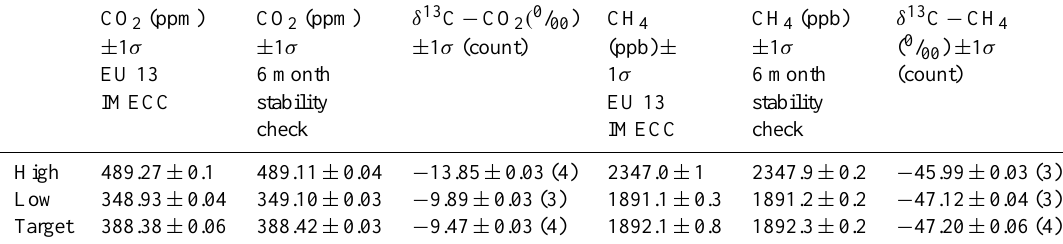
Table 1. The in-flight gas standards certified mole fractions used during the BORTAS and MAMM projects. The Max-Planck Institute for Bio- geochemistry (Jena) carried out the calibration through the Infrastructure for Measurements of the European Carbon Cycle (EU 13 IMECC) project. A 6month-mixture stability check showed the standards were stable over this period. The δ 13 C isotopic ratios, determined using continuous-flow gas chromatography/isotope-ratio mass spectrometry (Fisher et al., 2006), are close enough to the ambient isotopic ratio so as not to cause a significant error in the measured mole fractions.